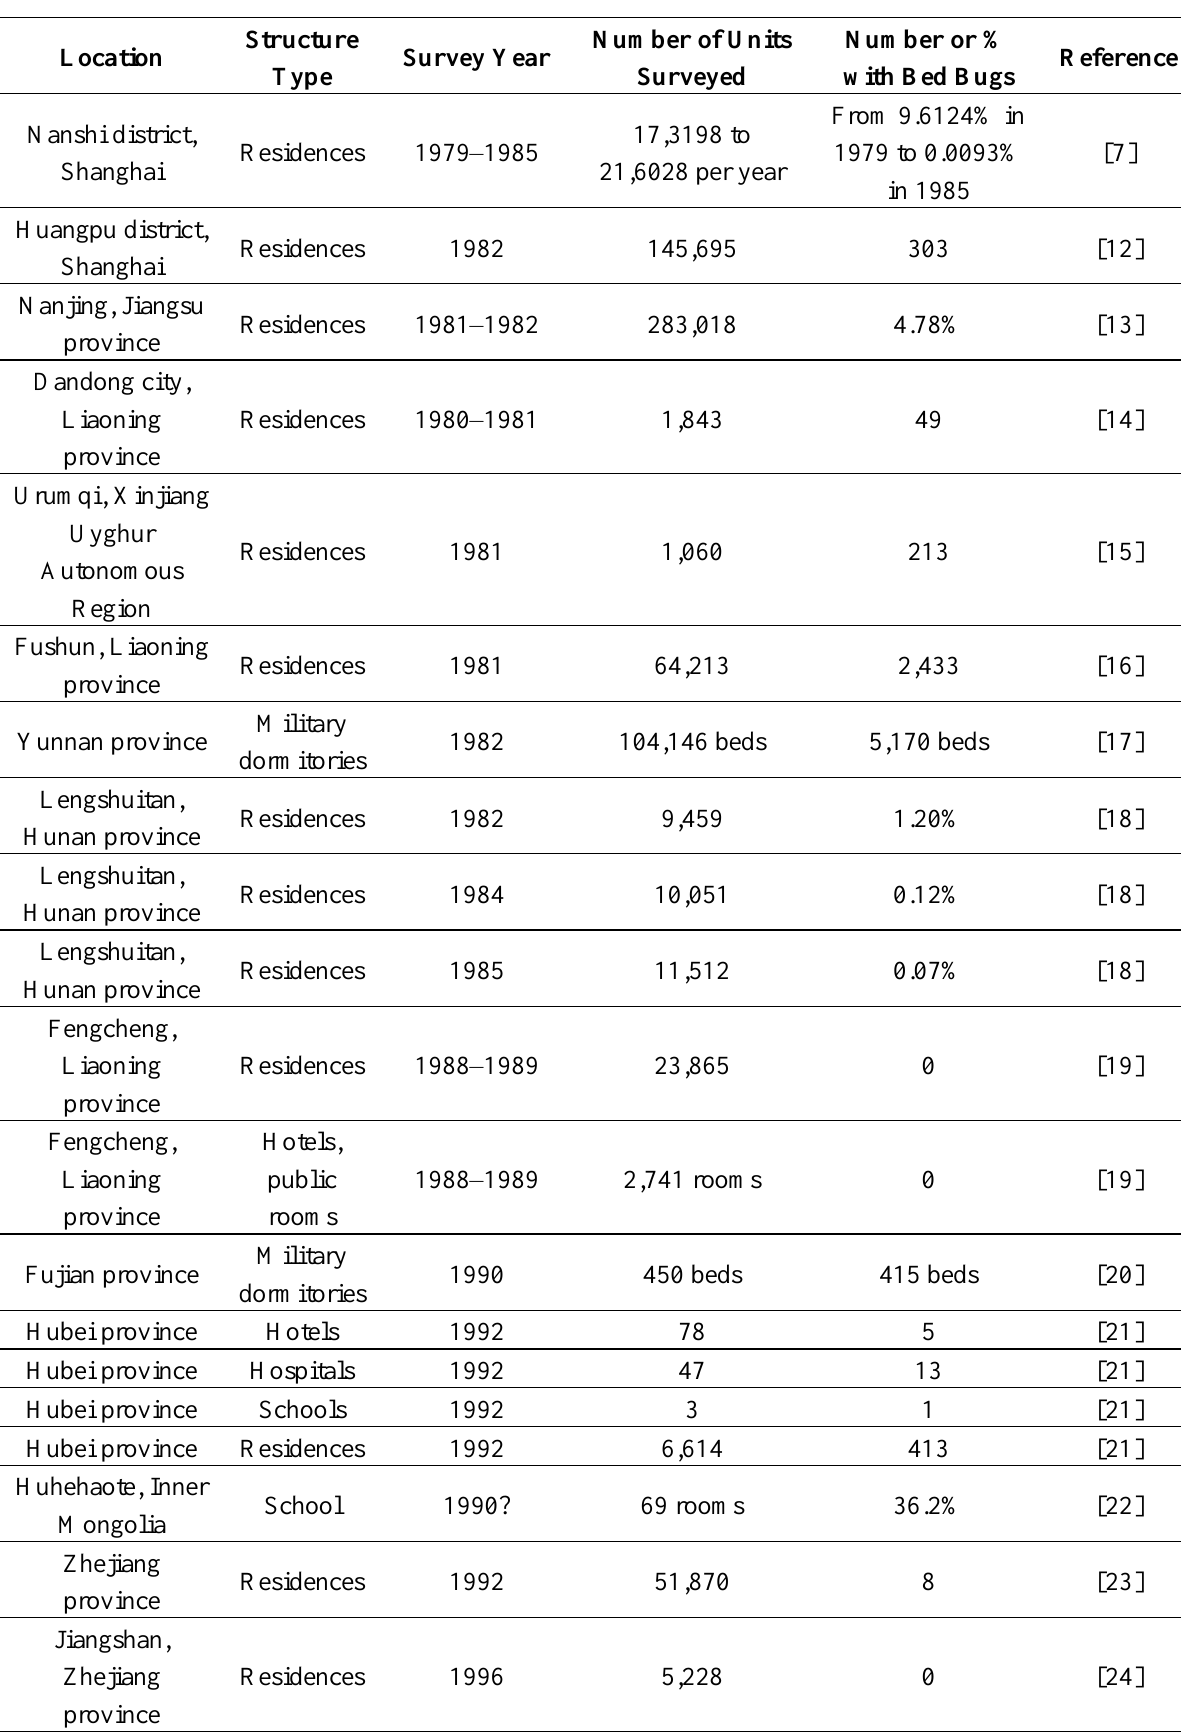
Table 1 . Summary of reported bed bug infestation statistics in China.